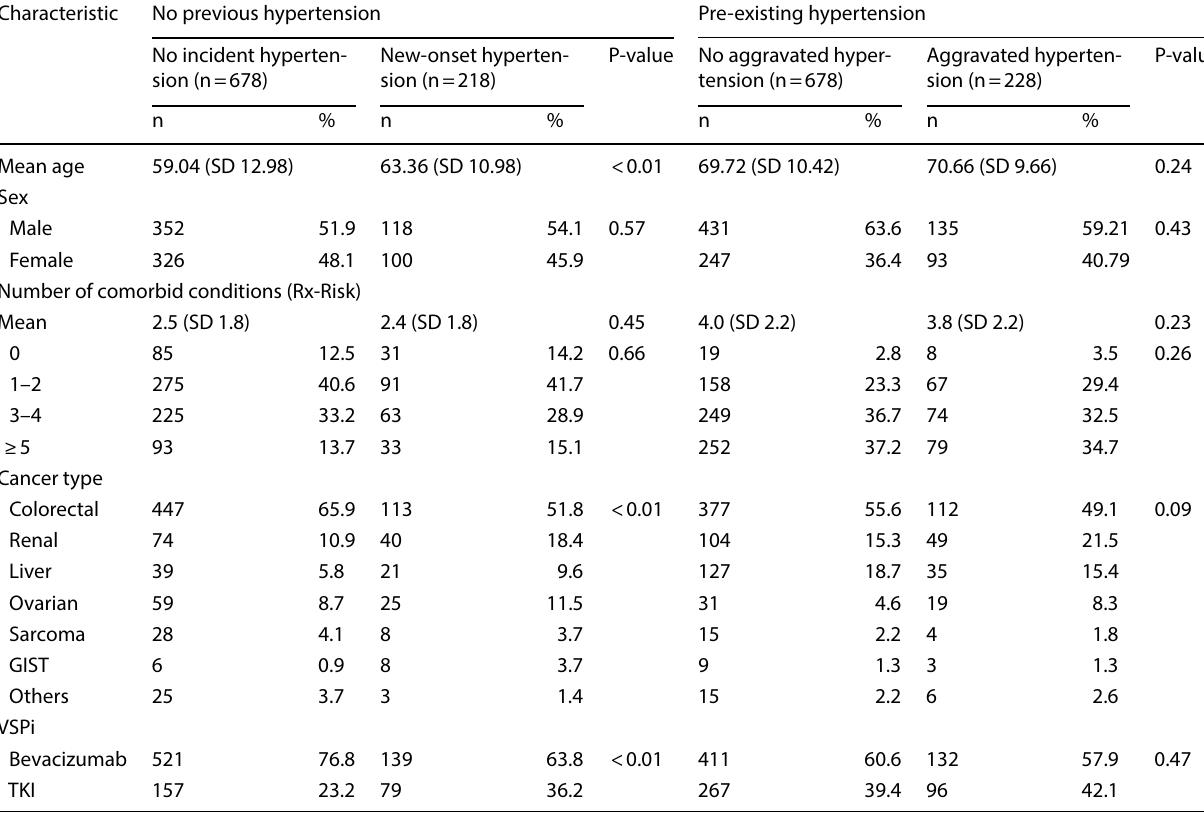
GIST gastrointestinal stromal tumour, TKI tyrosine kinase